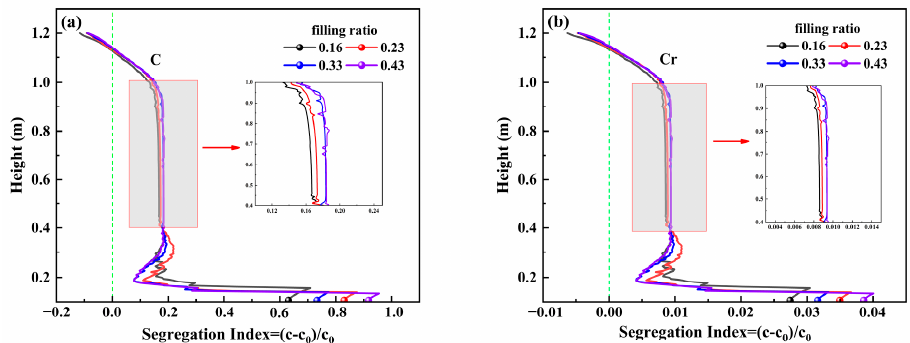
Figure 21. Change of C ( a ) and Cr ( b ) centerline segregation index with varying filling ratio.